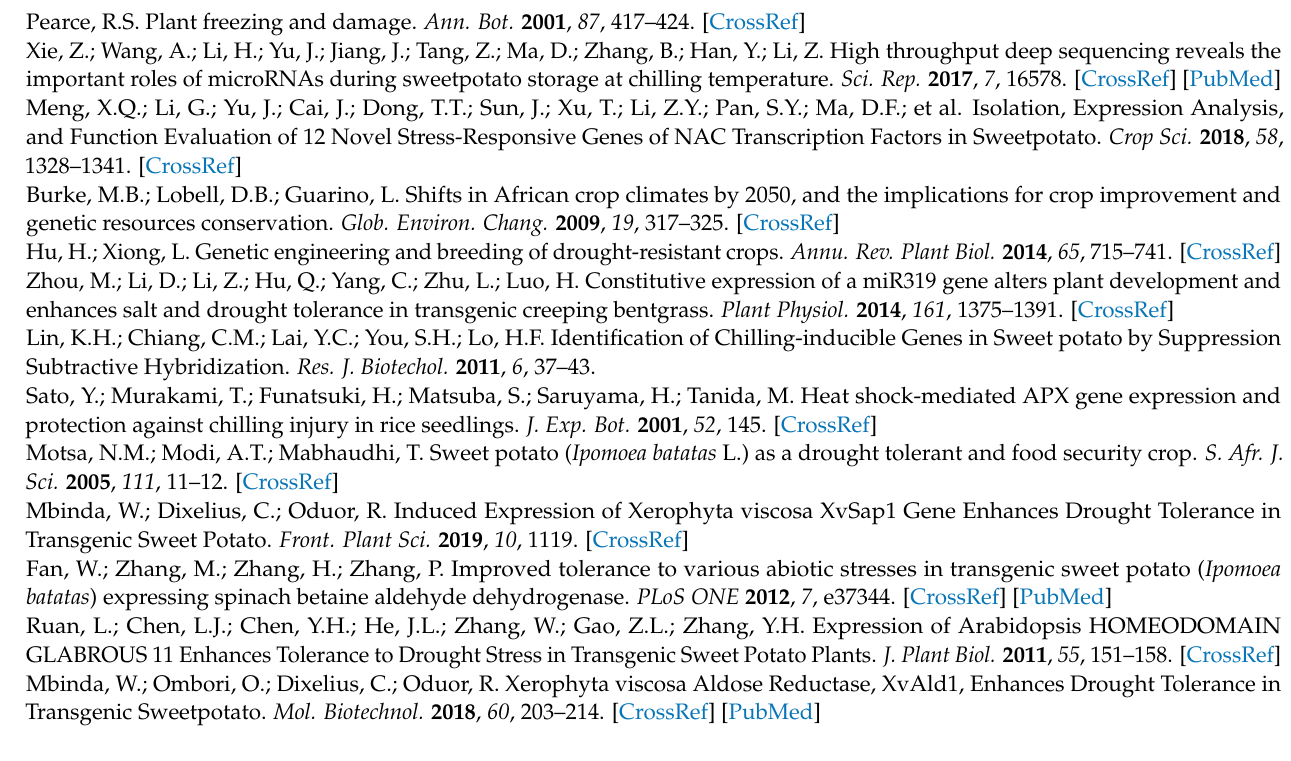
transverse freehand section in MIM319 transgenic sweet potato and WT. Figure S5: Lignin deposition patterns in the stem of the third internode freehand transverse section staining with toluidine blue (TB) and vertical paraffin section staining with Safranin O-Fast Green. Figure S6: Validation of the transcriptome sequencing results. Table S1: Primers used in this study. Table S2: List of the differentially expressed genes (DEGs) between MIM319 transgenic sweet potato and WT. Table S3: GO analysis of DEGs. Table S4: KEGG pathway enrichment